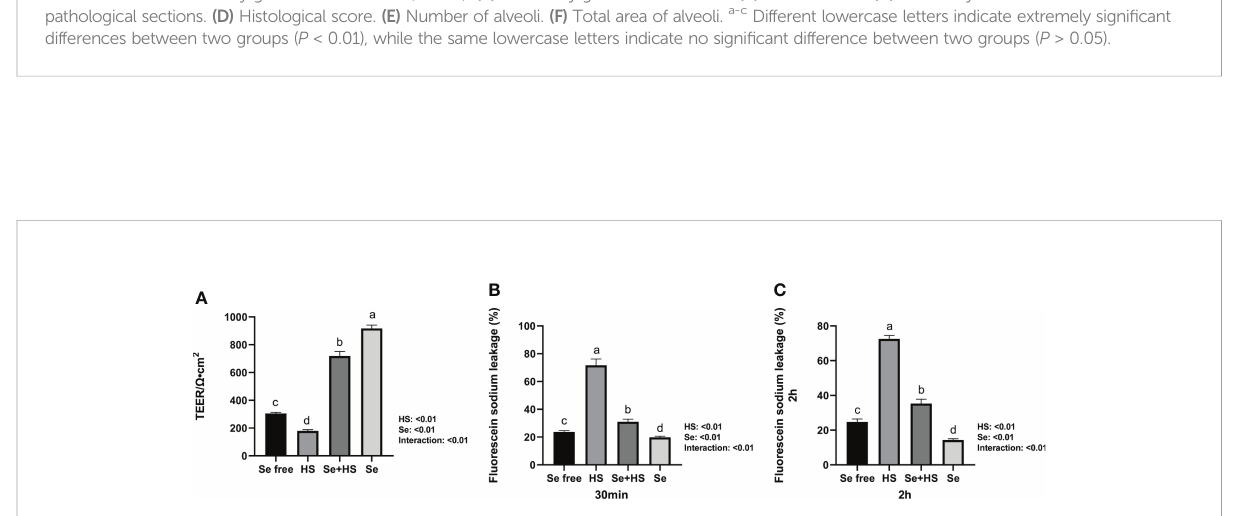
FIGURE 5 Effects of HMSeBA on permeability of monolayer BMECs under HS (n = 9). (A) TEER. (B) Fluorescein sodium leakage (30 min). (C) Fluorescein sodium leakage (2 h). a-d Different lowercase letters indicate extremely signi fi cant differences between two groups ( P < 0.01), while the same lowercase letters indicate no signi fi cant difference between two groups ( P > 0.05). BMECs means bovine mammary epithelial cells. TEER means transepithelial electrical